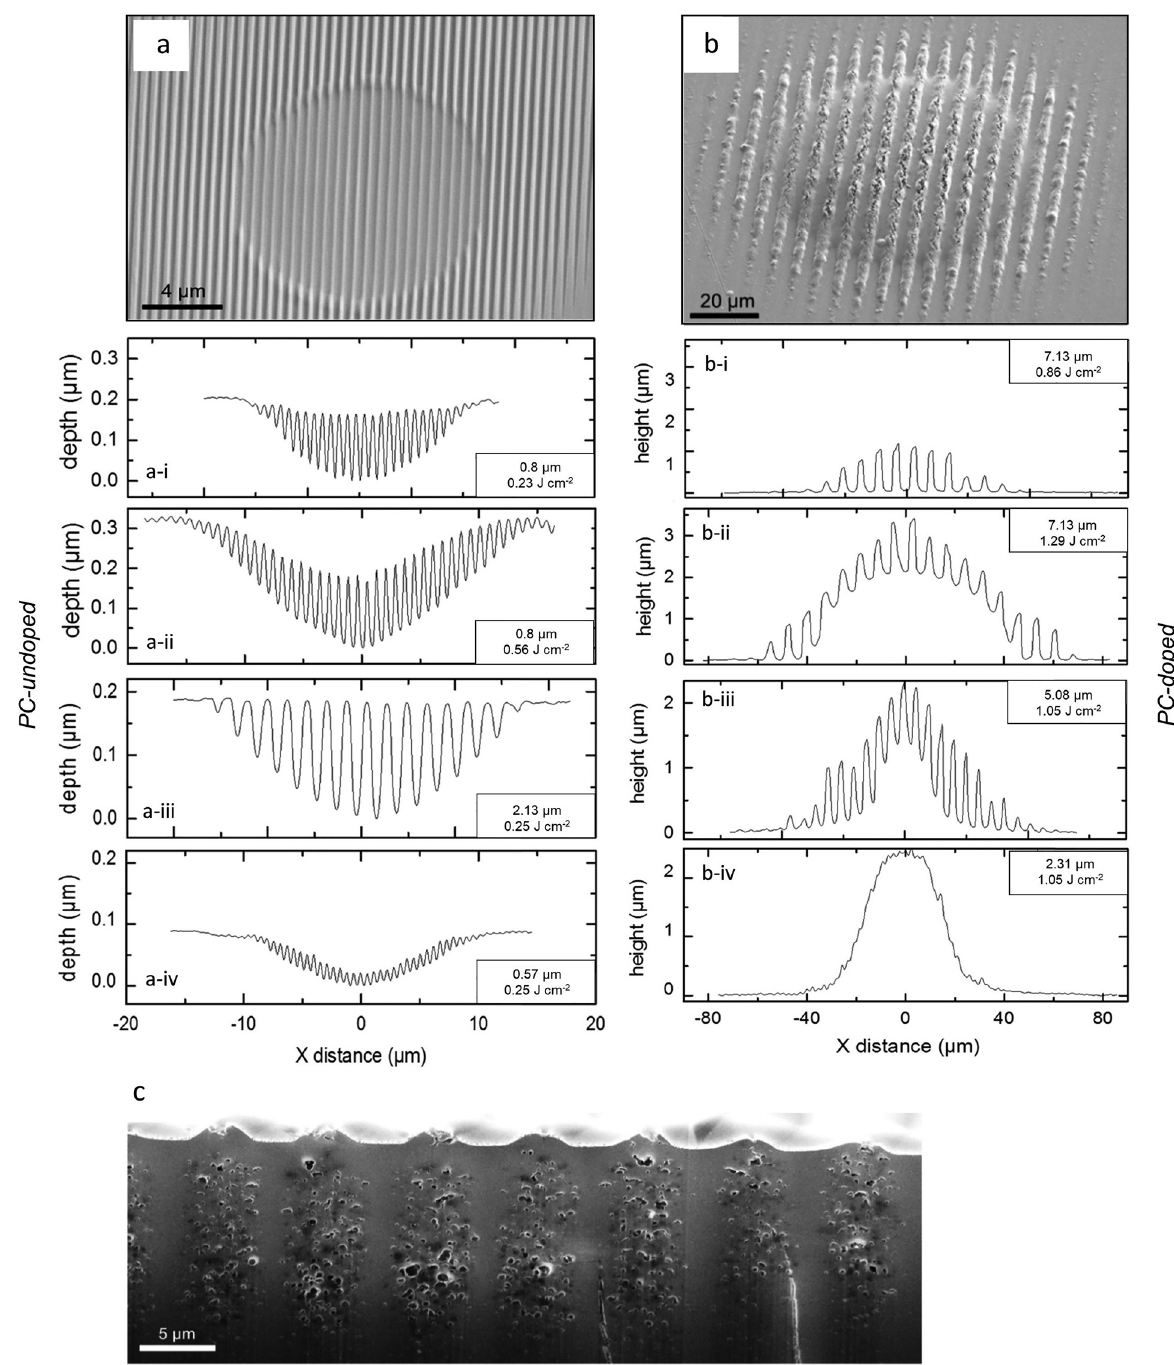
Figure 9: Left column: PC-undoped-DLIP line-like at a wavelength of 263nm (a) SEM image of one Gaussian spot(pulse duration 3 ns, fl uence 3.5 J cm − 2 , spatial period 0.56 µm), the shaded region forming a circle corresponds to the center of the laser spot where there is a depressed zone (zone of higher fl uence) while the surrounding zone corresponds to the area of lower fl uence. Confocal microscope pro fi les at a fi xed periodbutvaryingthelaser fl uence(a-i,ii)and fi xed fl uencebutvaryingthespatialperiod(a-iii,iv).Rightcolumn:PC-doped-DLIPline-likewith swellingat 1053 nm(b) SEM imageof one Gaussianspot.Confocalmicroscopepro fi les of at a fi xed periodbut varyingthelaser fl uence (b-i,ii) and fi xed fl uence but varying the spatial period. (a-iii, iv). The black box in each graphic indicates the fl uence and the spatial period of structuring. (c) SEM-FIB image of a swelled PC-doped-DLIP line-like (1053 nm, fl uence 1.3 J cm − 2 , period 7.3 µm). Reproduced from ref. [22] (© 2017, Optical Society of